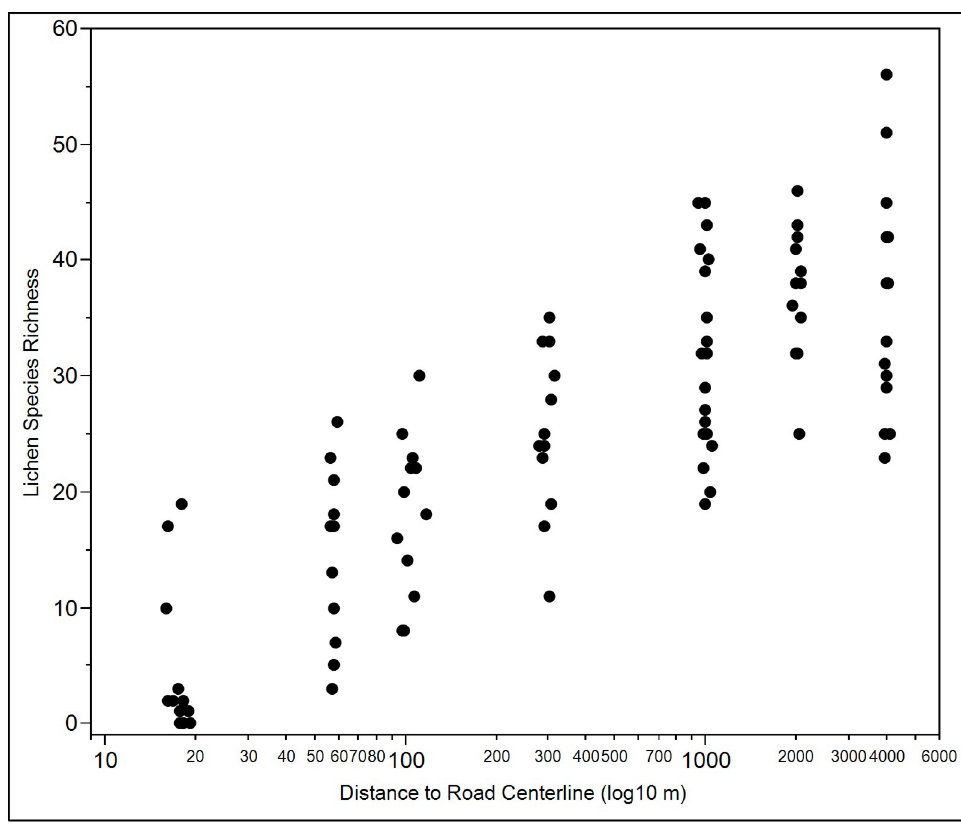
Fig 3. Lichen species richness versus the log 10 of distance to the DMTS haul road in Cape Krusenstern National Monument, Alaska. Lichen species richness in 94 vegetation plots (4 x 8 m) between 10–4000 m from the road, Cape Krusenstern National Monument,